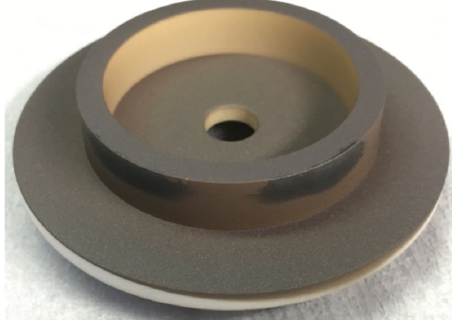
FIG. 10. The DLC-coated MgO cell of DAA2-1-DLC after the conditioning process. The traces of the breakdown were observed at the contact point between the dielectric cell and the adjacent dielectric cell and at the contact point between the dielectric and the copper end plate. Those traces are at the outside surface of the dielectric cylinder adjacent to the